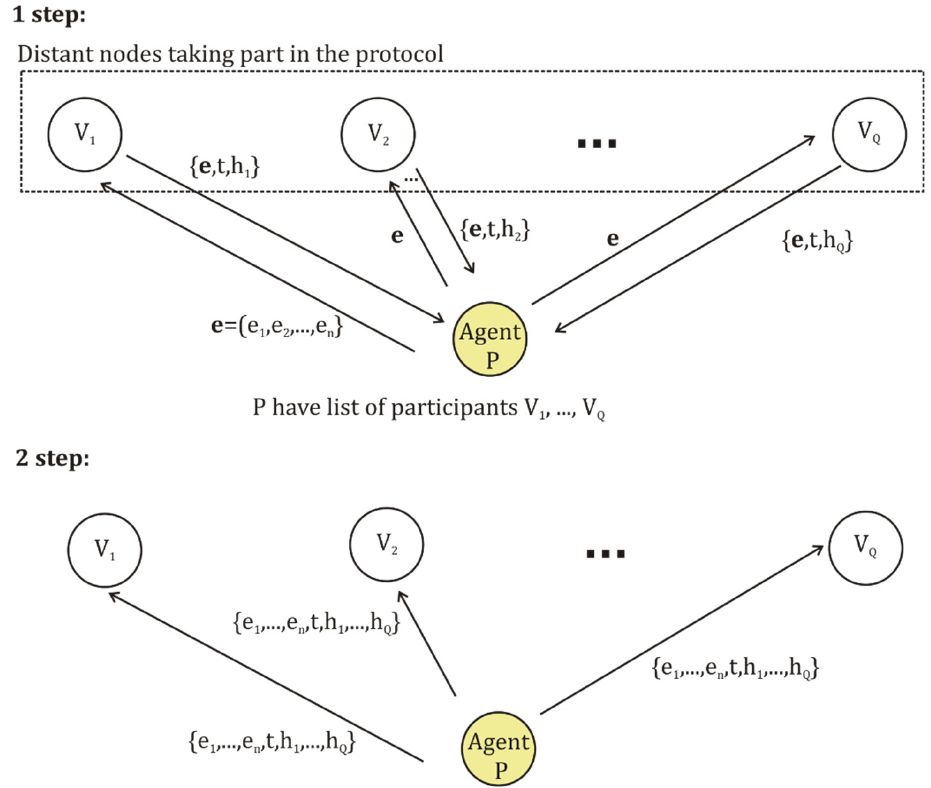
Figure 4. The scheme of assigning random hash values ℎ by verifiers to the entry received from the mobile agent